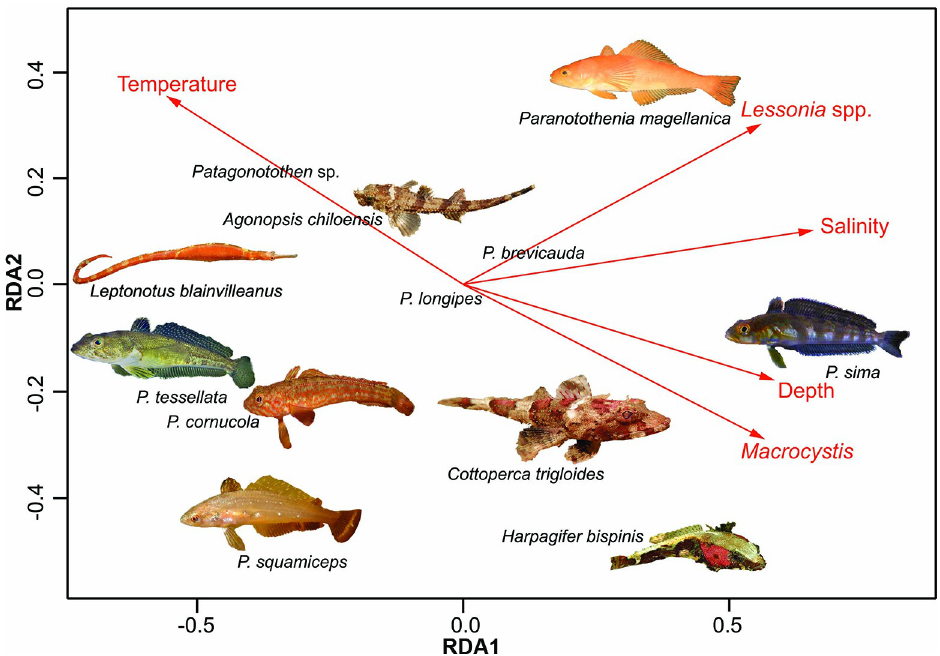
Fig 5. Redundancy Analysis (RDA) ordination biplot with environmental factors influencing fish assemblage structure. Species with low abundance were not included in this biplot. P . = Patagonotothen spp.